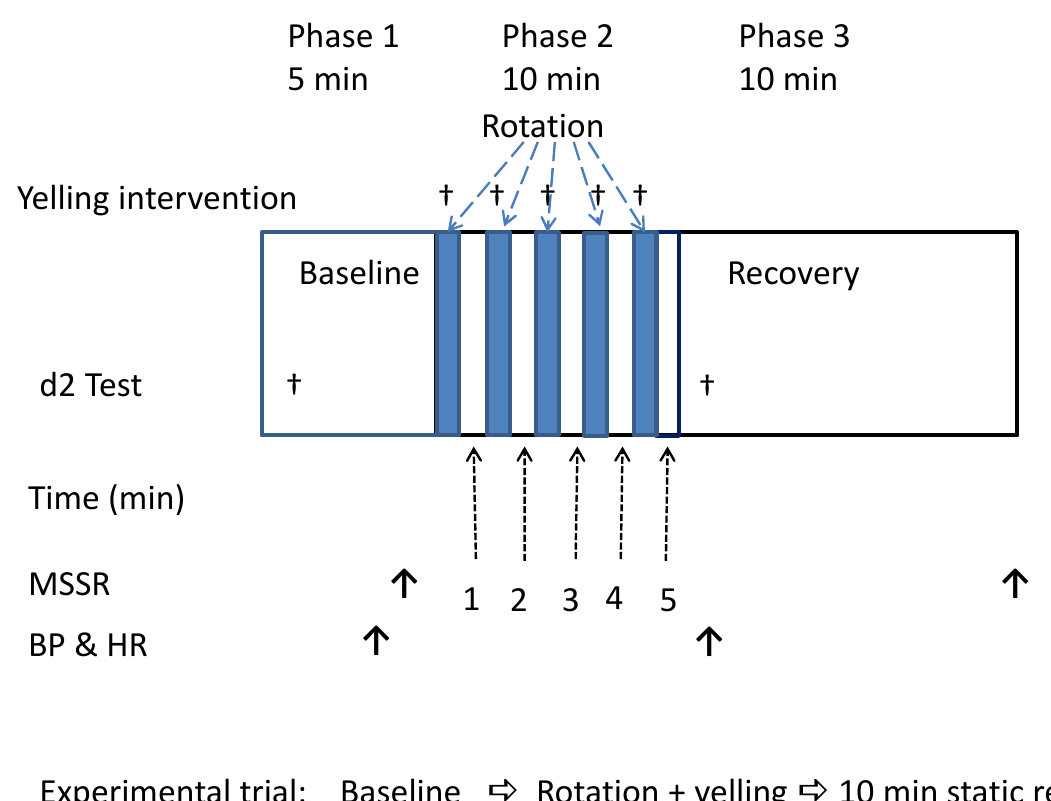
Figure 1. Experimental procedure and detection time of each parameter. BP = blood pressure; HR = heart rate; MSSR = Motion Sickness Symptom Rating.